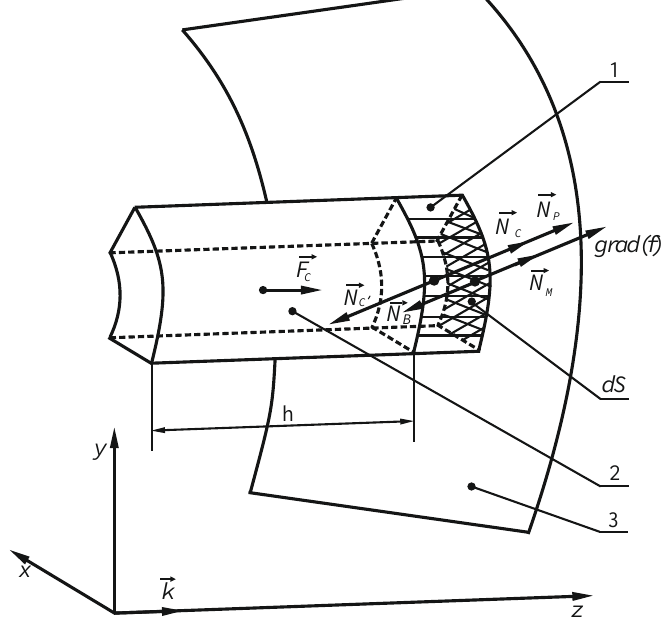
Figure 7. Schematic representation of interaction between the flow of accelerated material 1, which is in contact with the elementary area of the screw surface dS , and the horizontal layer 2 in the form of an oblique cylinder with a base dS and a height equal h , the screw pitch (balanced gravity forces and responses are not shown); grad ( f ), the gradient vector to the surface f ; 𝑁 𝑃 ⃗⃗⃗⃗⃗⃗ , the pressure applied by the upper layers of the material on the volume interacting with the elementary area 𝑑𝑆 ; 𝑁⃗⃗⃗ 𝑀 , normal force; 𝑁 ⃗⃗⃗ 𝐵 , the force with which an elementary area of the screw surface impacts the material when in steady motion; 𝑁 𝐶 ⃗⃗⃗⃗⃗⃗⃗ , the force that overcomes the friction force 𝐹 𝐶 ⃗⃗⃗⃗⃗⃗ Force 𝑁 𝑃 ⃗⃗⃗⃗⃗⃗ is the pressure applied by upper layers of the material on the volume in- teracting with the elementary area 𝑑𝑆 (Figure 7). It is determined by analogy with the pressure in a liquid, but on condition that the moving surface provides compressive stresses to the considered volume of bulk material (that is, there is no pressure from the rear side of the screw surface). Force 𝑁 𝑃 ⃗⃗⃗⃗⃗⃗ acts as the force of static pressure of the upper layers on the lower ones, assuming equality in all directions, similar to Pascal’s law for liquids: